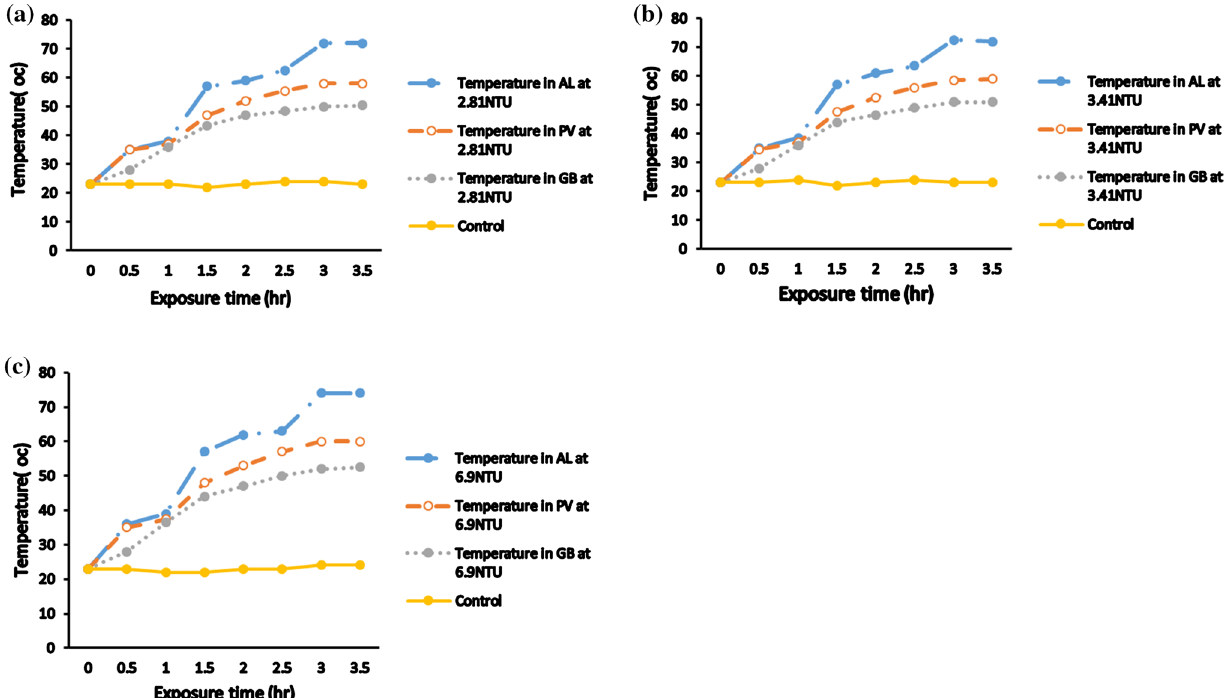
Fig. 6 Comparison between aqua lens, photovoltaic and glass bot- tle temperature concentrating potential at different turbidity levels. a Temperature concentrating potential of concentrators at 2.81 NTU. b